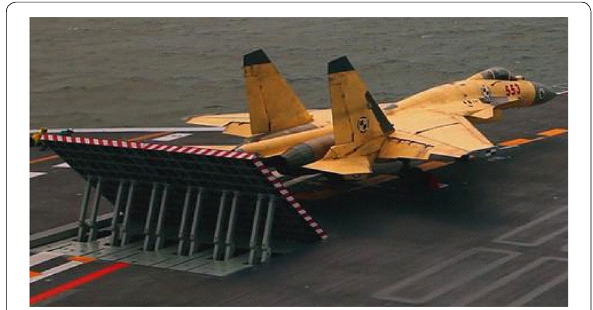
Figure 3 Computational model of a jet blast deflector